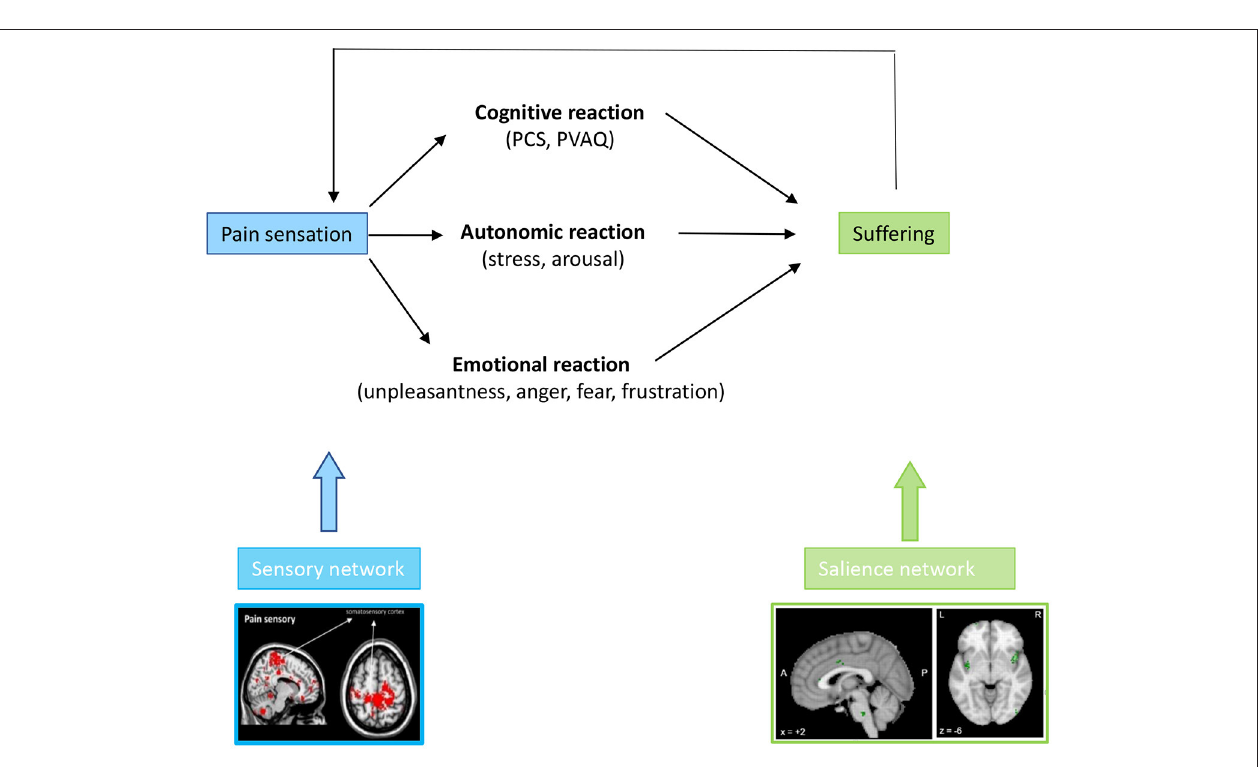
FIGURE 5 | A chronic painful stimulus leads to a cognitive, emotional, and autonomic response, which phenomenologically expresses as catastrophizing, attention paid to the pain, unpleasantness, fear, anger or frustration with pain and arousal/distress. These cognitive, emotional, and autonomic symptoms are all phenomenological expressions of altered activity in the medial